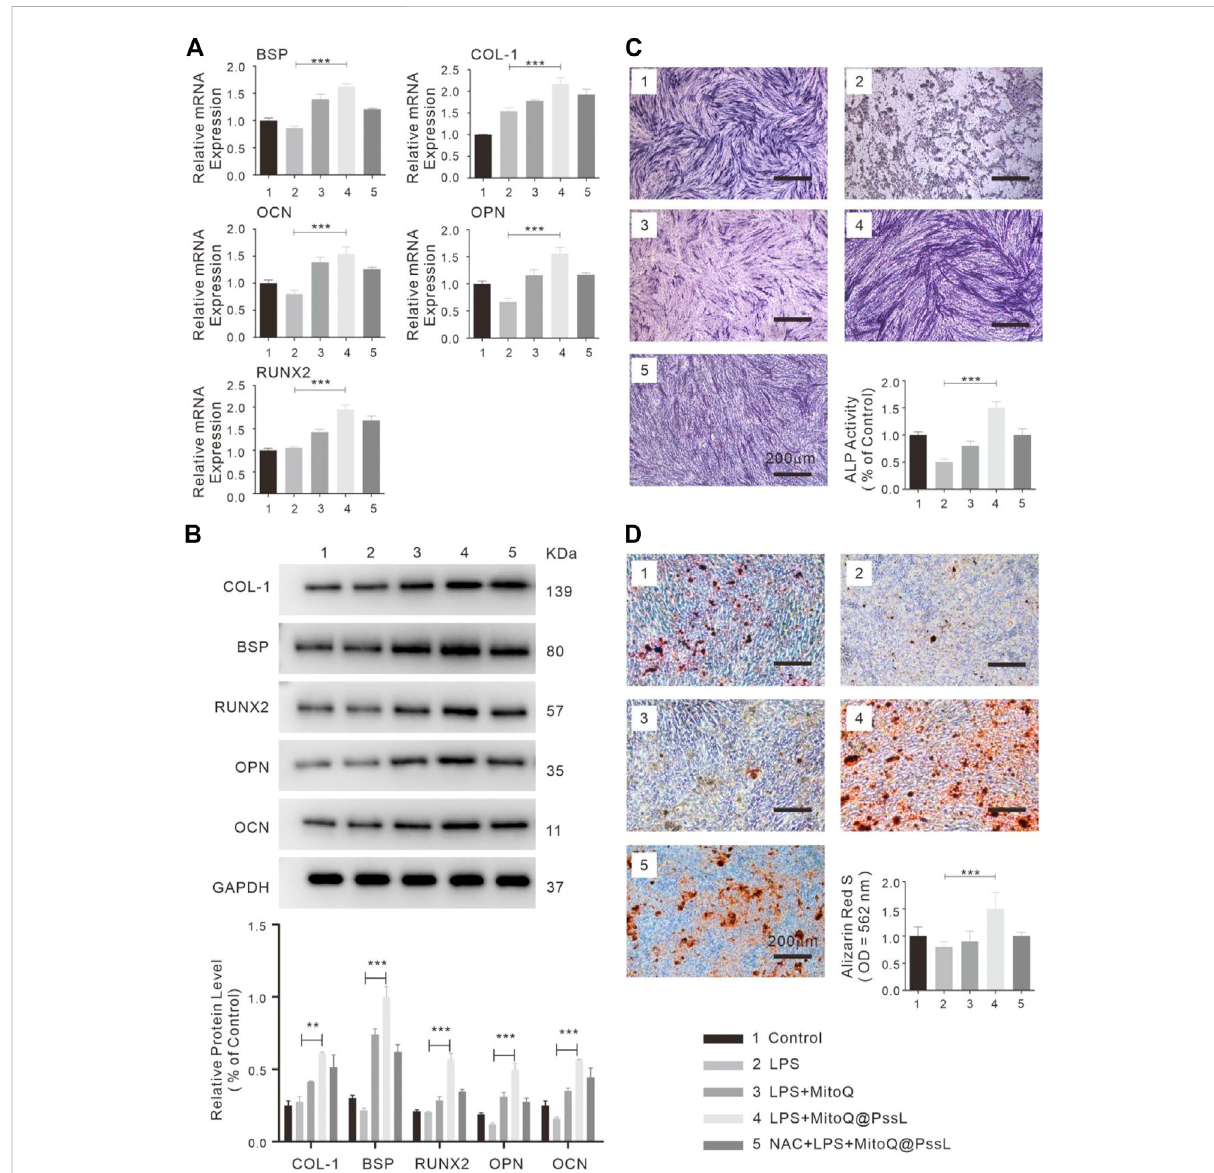
FIGURE 4 The osteogenic differentiation of hPDLSCs treated with MitoQ@PssL NPs (1: Control, 2: LPS, 3: LPS + MitoQ, 4: LPS + MitoQ@PssL NPs, and 5: NAC + LPS + MitoQ@PssL NPs). (A) Osteogenic related gene expression on day 7. (B) Osteogenic related protein experssions of hPDLSCs on